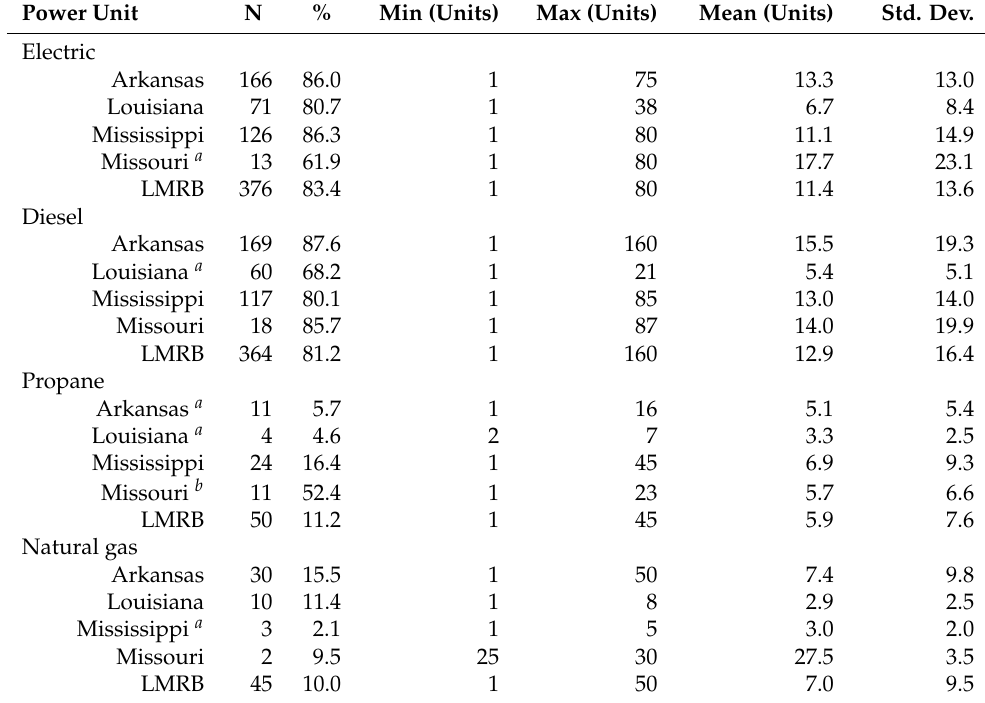
Table 9. Summary statistics of groundwater pumping energy